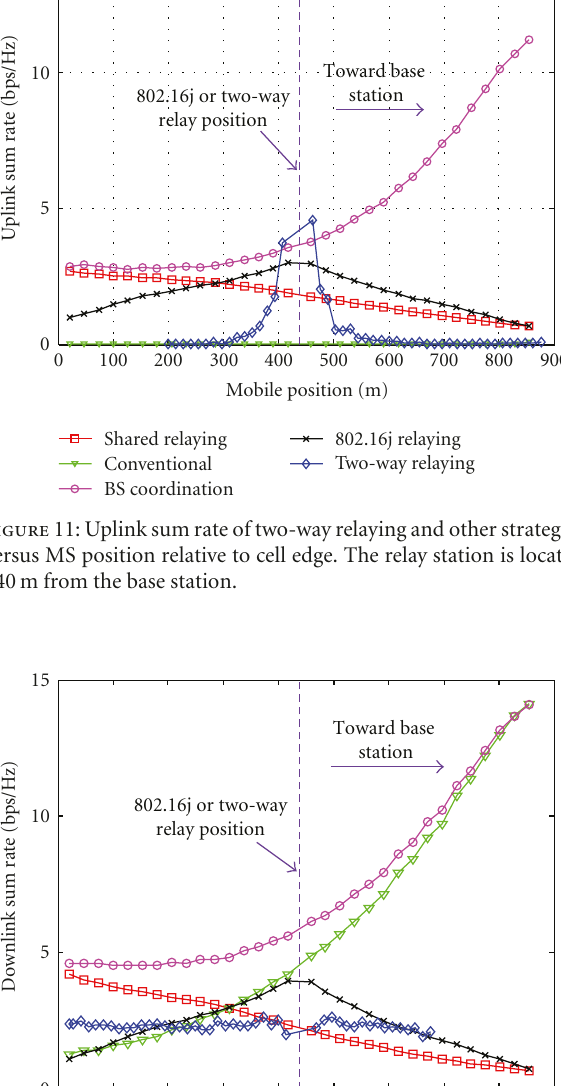
same strategies. In this case, the relay station is located 440 m from the cell edge. The mobile’s power begins to overshadow the adjacent BS interference power at around 100 m from the relay, and the sum rate quickly